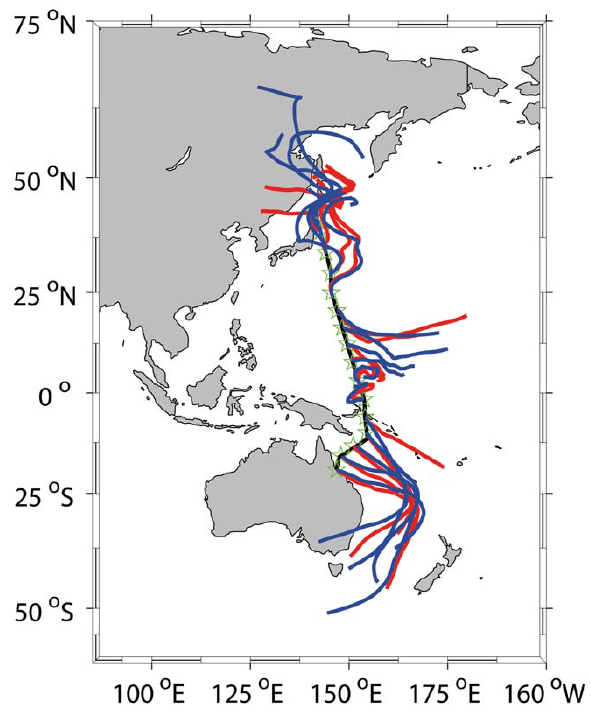
Fig. 5. 5-day backward trajectories calculated with the HYSPLIT (NCEP-GDAS data, red lines) and BADC (opECMWF 1.125 ◦ × 1 . 125 ◦ data, blue lines) models, started daily at 00:00UTC along the cruise track, and at 500m altitude and 950hPa pressure level,